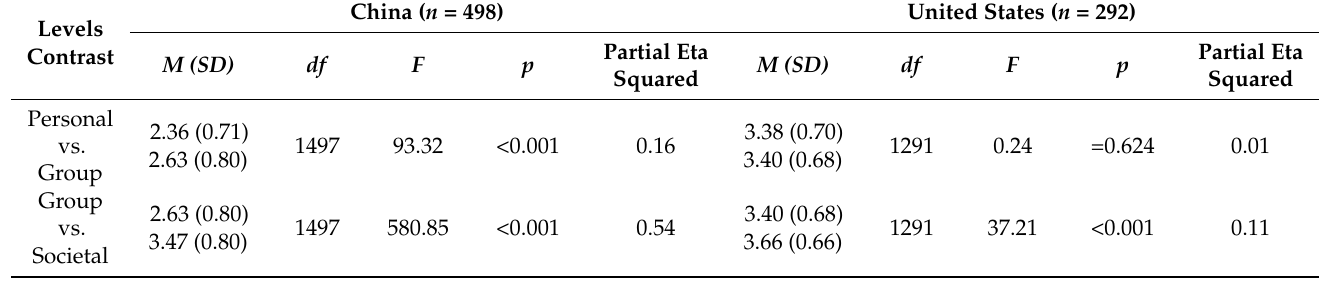
Table 2. Repeated measures ANOVA and within-subjects contrasts tests on risk perceptions at three levels in two countries. Levels Con- trast